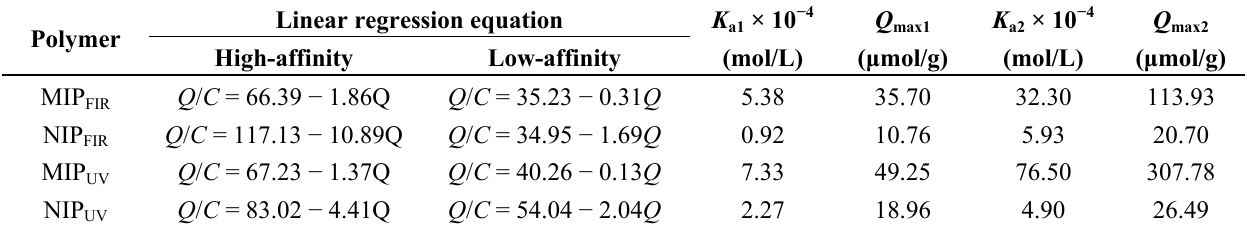
Table 2. The adsorption parameter of MIPs and NIPs.